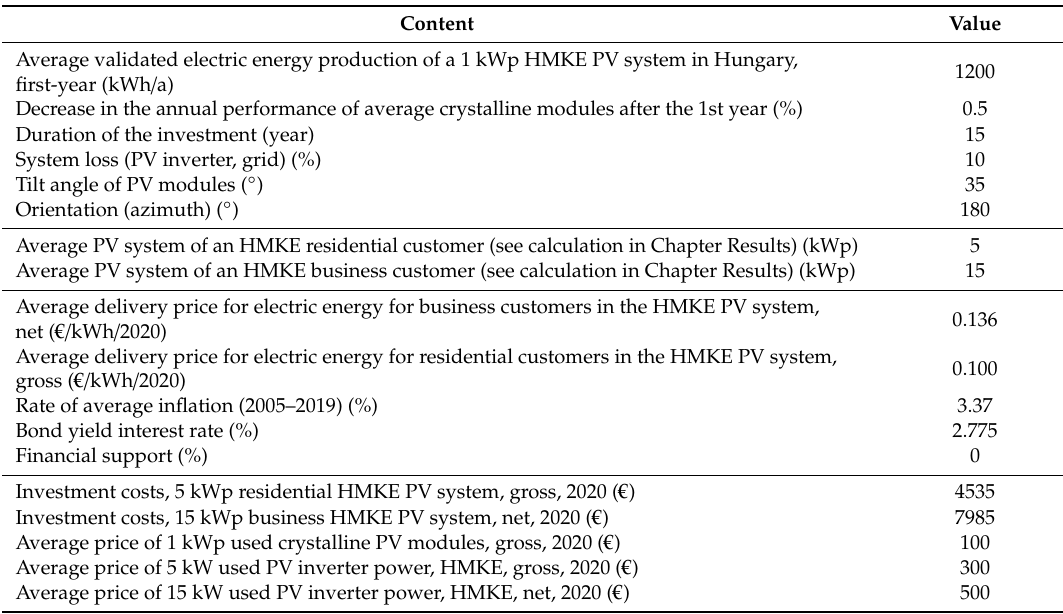
Table 2. The initial economic–technical data for the calculations